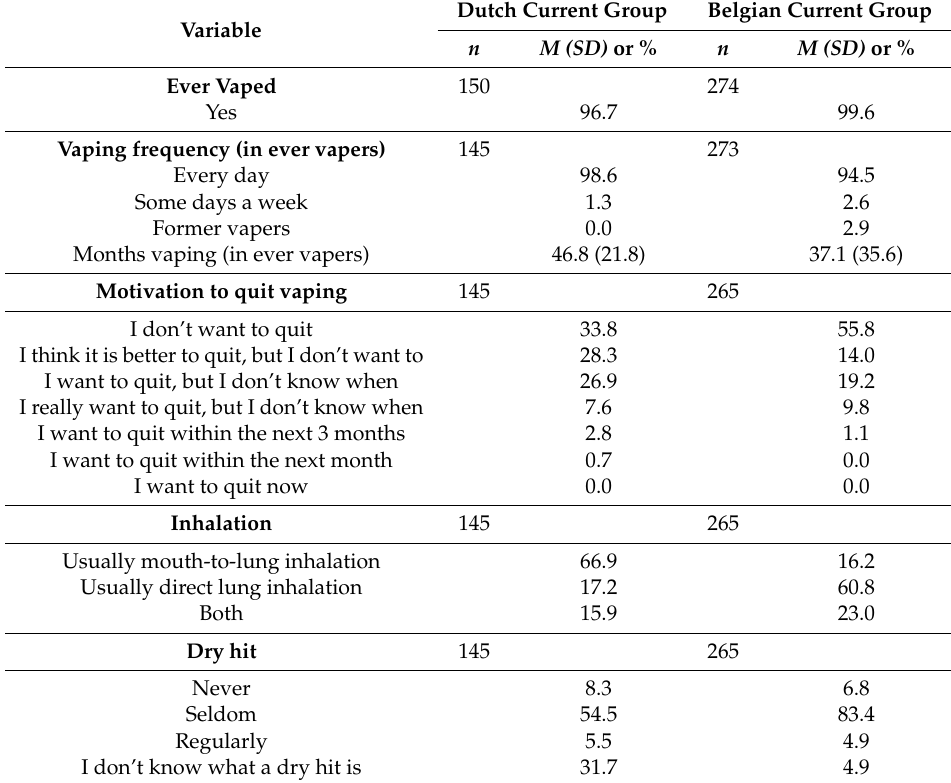
Table 1. Vaping history and current vaping status for the Dutch Current/Belgian Current